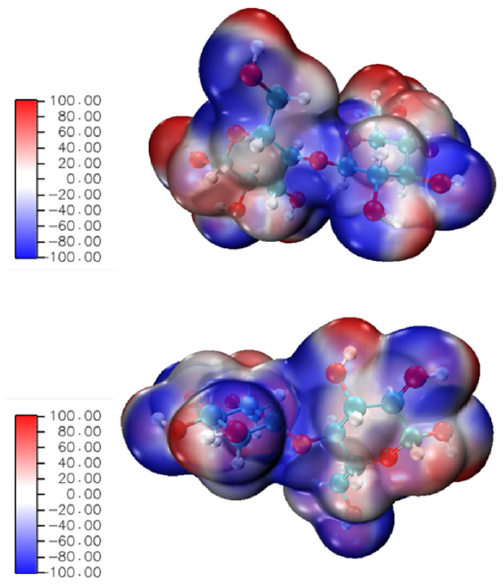
Figure 7. Electrostatic potential of cellobiose molecule.